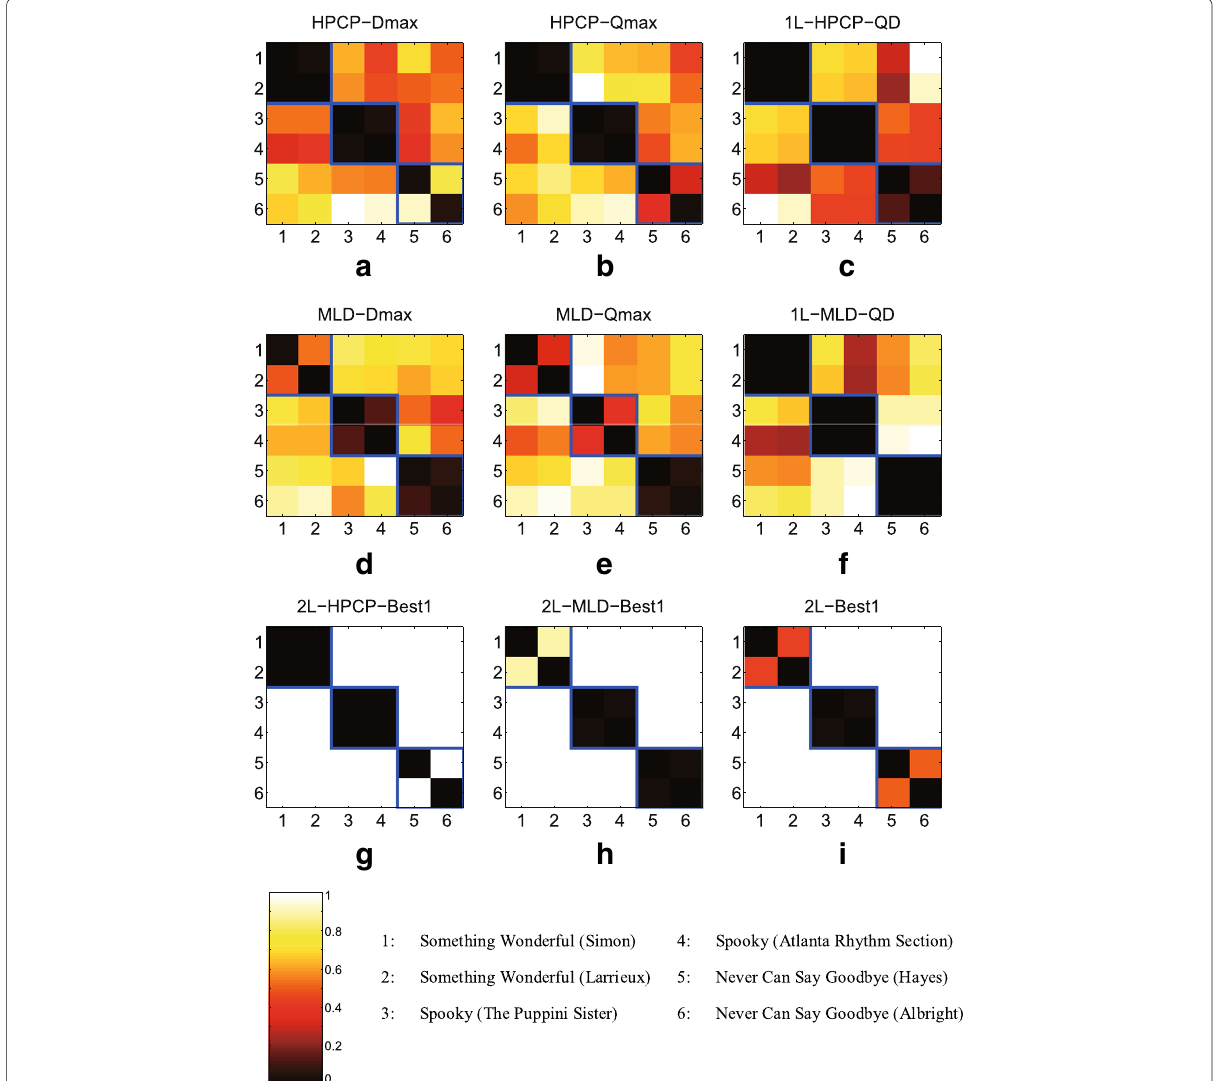
Fig. 4 Distance matrices obtained by CSI schemes with or without similarity fusion. The actual values are subtracted by 1 to make the